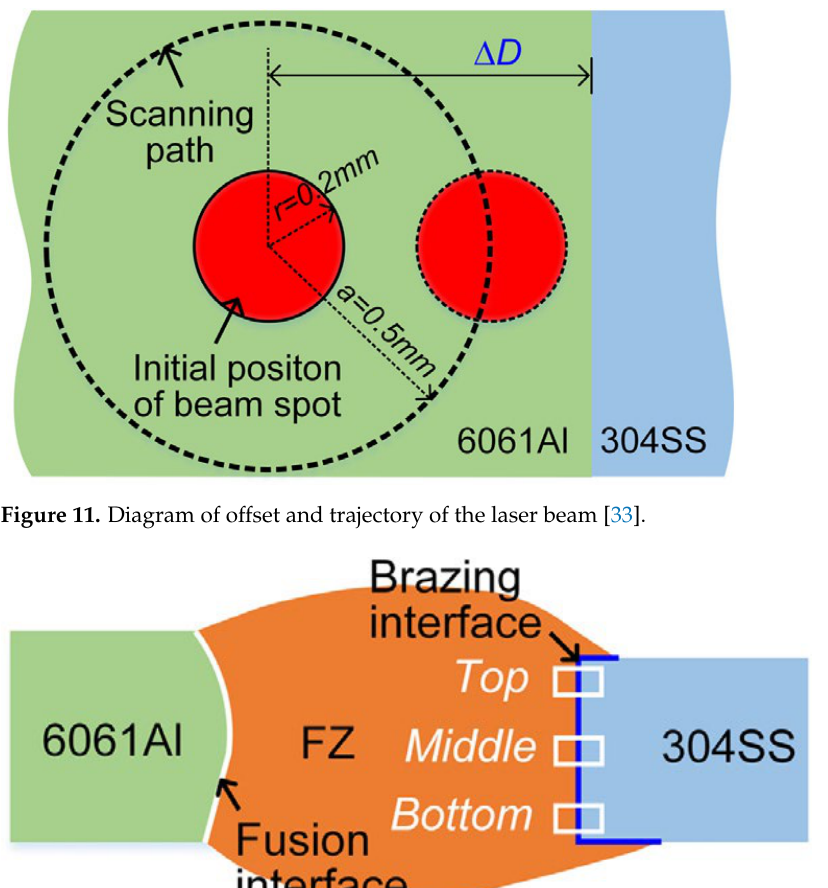
Figure 12. Schematic diagram of the macrostructure of the joint under study and a part of a detailed study of the microstructure (top, middle, bottom) [33].